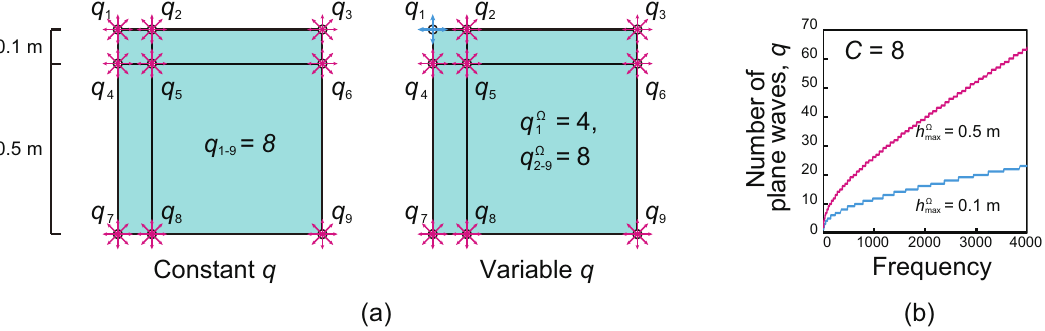
Figure 1. An example of q -refinement using the Constant q - and Variable q -approach: ( a ) the difference between Constant q and Variable q in the element patch composed of a 0.1 m × 0.1 m square element, two 0.5 m × 0.1 m rectangular elements, and a 0.5 m × 0.5 m square element; ( b ) the change in the adding plane-wave number in the Variable q -approach at frequencies up to 4 kHz for the case with C = 8 when using h Ω = 0.5 m and 0.1 max, i